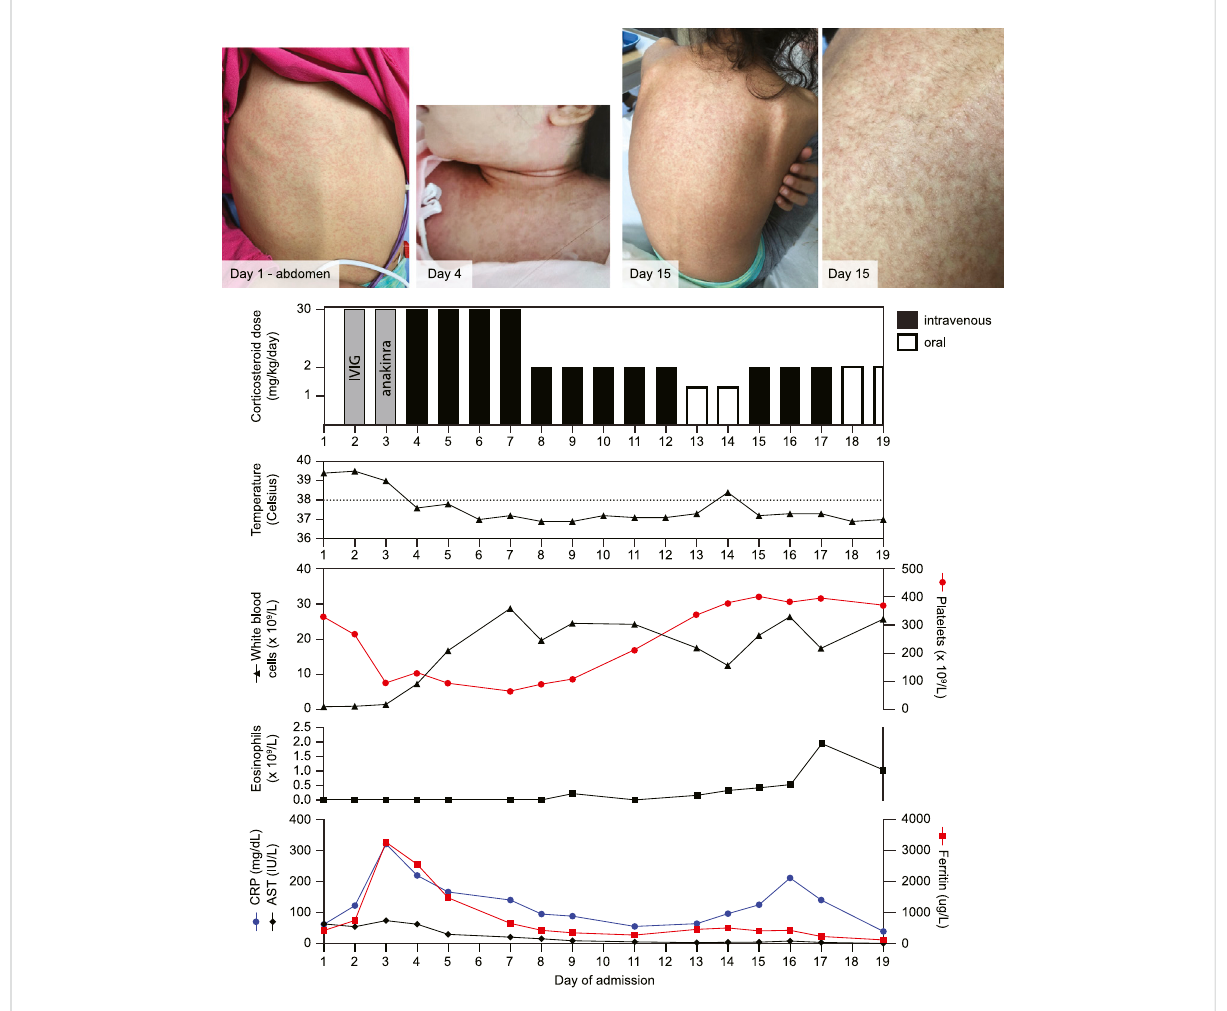
FIGURE 1 Evolution of the maculopapular rash alongside treatment timeline and laboratory investigations. Intravenous immunoglobulin (IVIG; 2 g/kg/ dose) and anakinra (3.7 mg/kg/dose) were both given once. CRP: C-reactive protein, AST: aspartate aminotransferase.